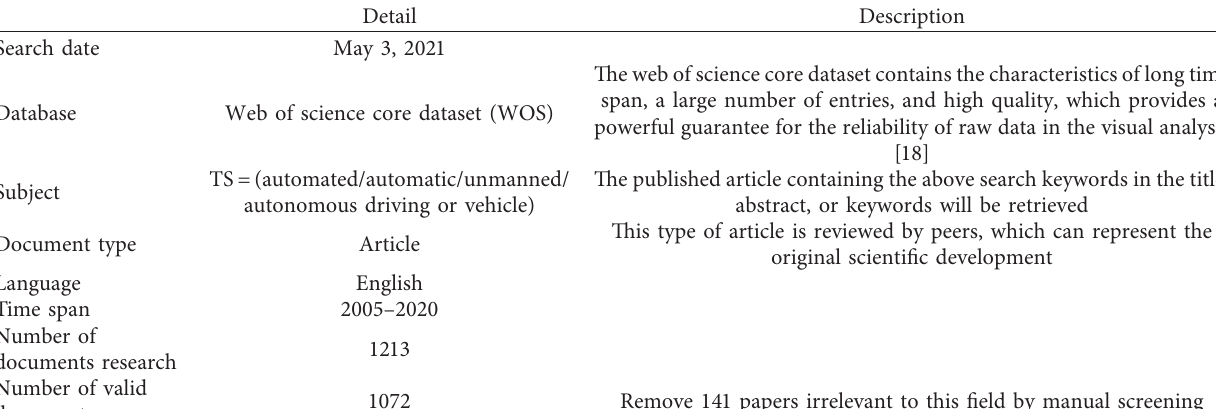
Table 1: Data source and processing